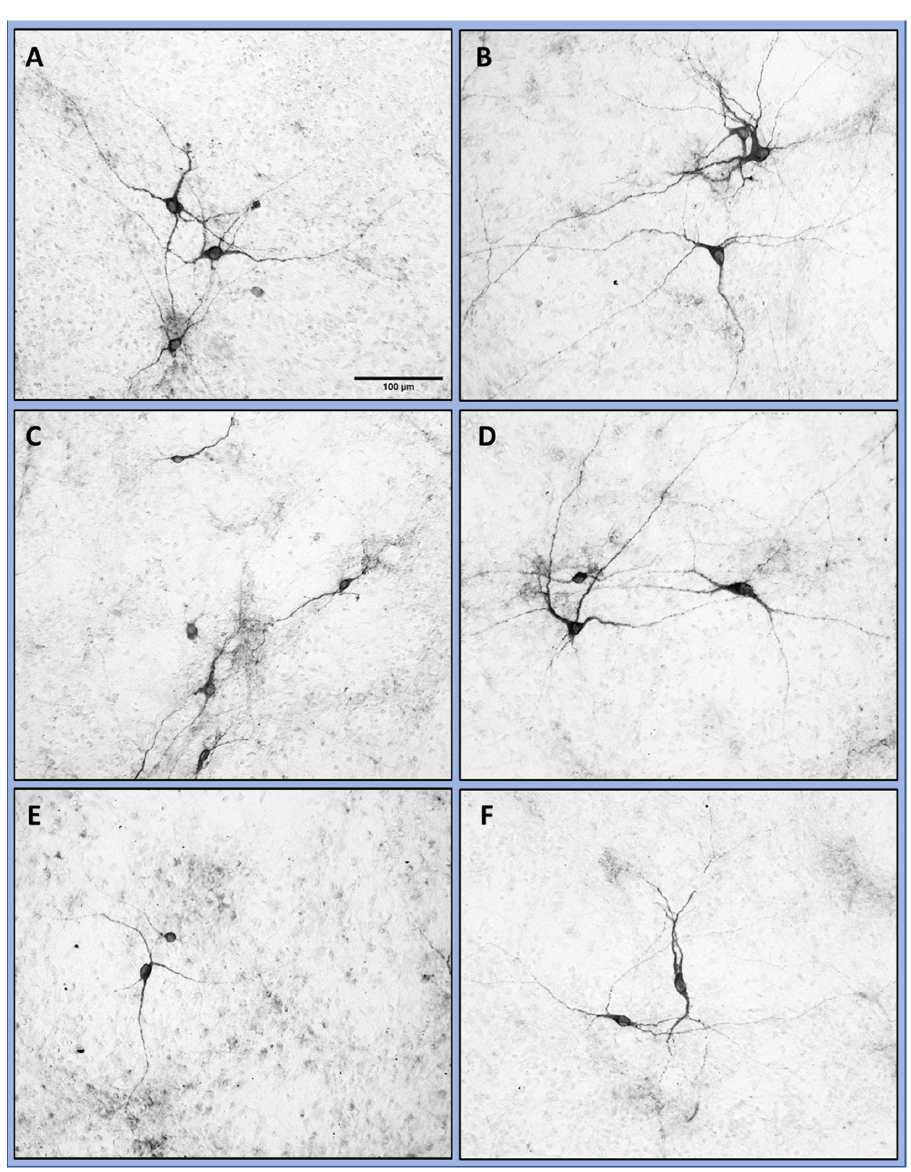
Figure 2. Representative photographs of the THir neurons under different conditions. ( A ) Neurons in the untreated controls (0 µM TQ, 0 nM rotenone, 0 µM MPP + ). ( B ) Neurons treated with 10 µM TQ. ( C ) Tyrosine hydroxylase positive neurons treated with 10 µM MPP+. ( D ) Cells concomitantly treated with 10 µM TQ and 10 µM MPP + . ( E ) Dopaminergic neurons treated with 20 nM rotenone. ( F ) THir neurons concomitantly treated with 10 µM TQ and 20 nM rotenone.